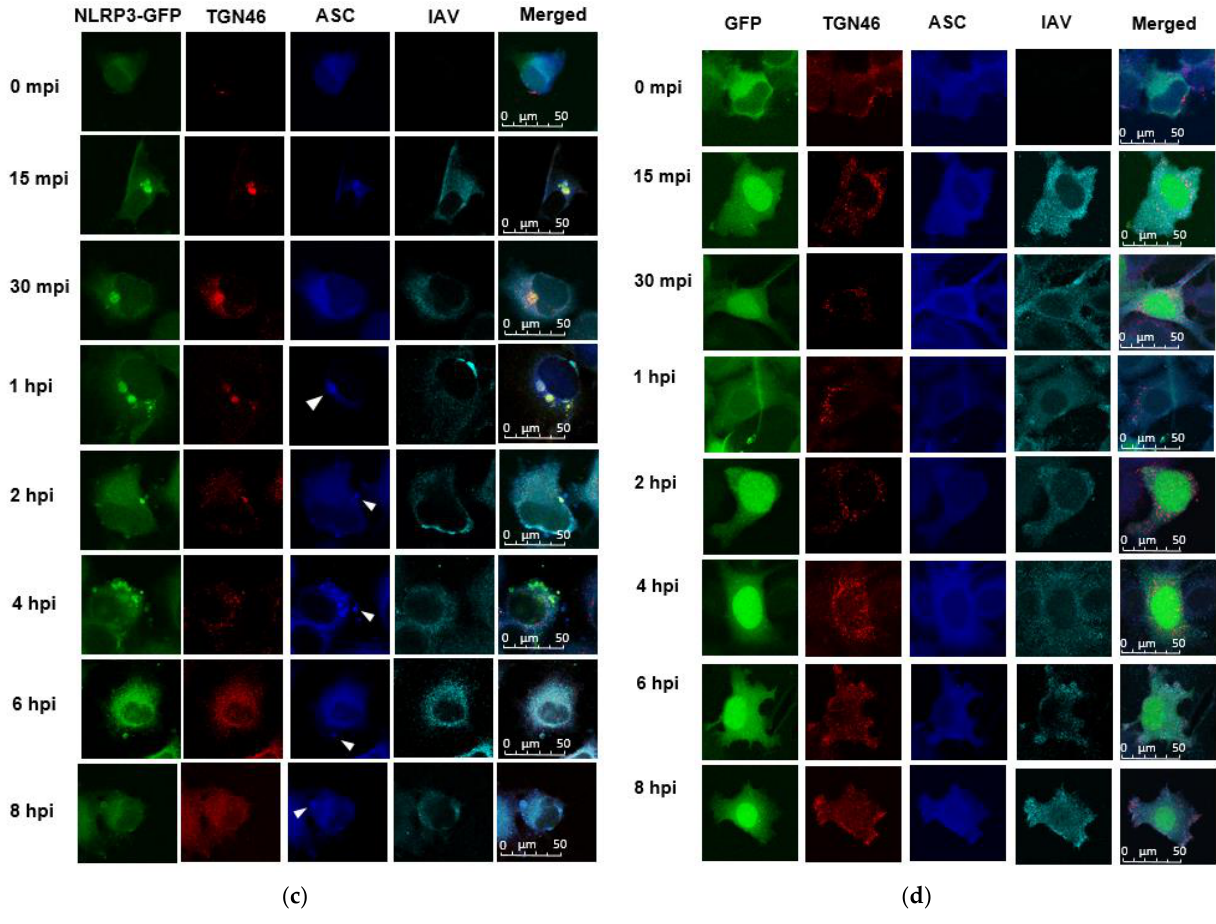
Figure 2. ASC is recruited to the site of dTGN-NLRP3. HeLa cells expressing ( a ) NLRP3-GFP or ( b ) GFP were infected with Sk02 at an MOI of 10. At indicated time points post-infection, cells were subjected to immunofluorescence for NLRP3 (green), TGN46 (red), and IAV (cyan). Scale bar, 25 μm. HeLa cells expressing NLRP3-GFP ( c ) or GFP ( d ) were transfected with a plasmid expressing ASC-Myc for 24 h and then were infected with Sk02 at an MOI of 10. At indicated time points, the cells were subjected to immunofluorescence microscopy for NLRP3 (green), TGN46 (red), ASC (blue), and IAV (cyan). The white arrows indicate the co-localization of NLRP3 and ASC. Scale bar, 50 μm.